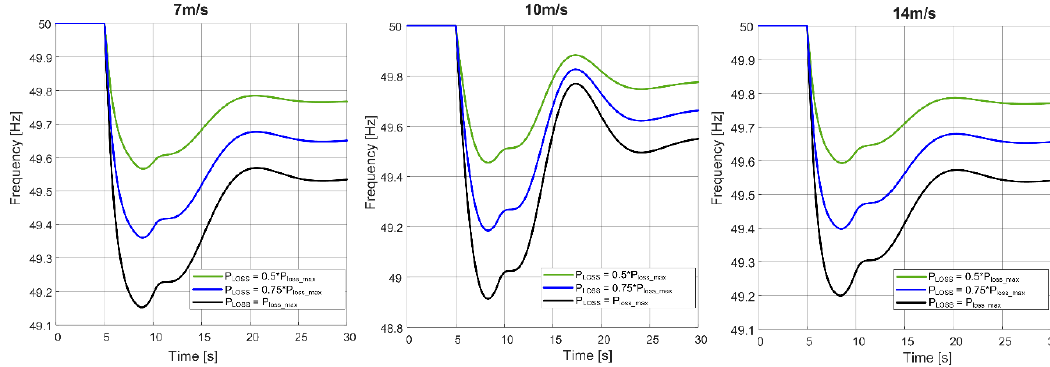
Figure 7. Impact of optimized parameters on power system frequency response for different contingencies with 7 m/s, 10 m/s, and 14 m/s wind speeds.